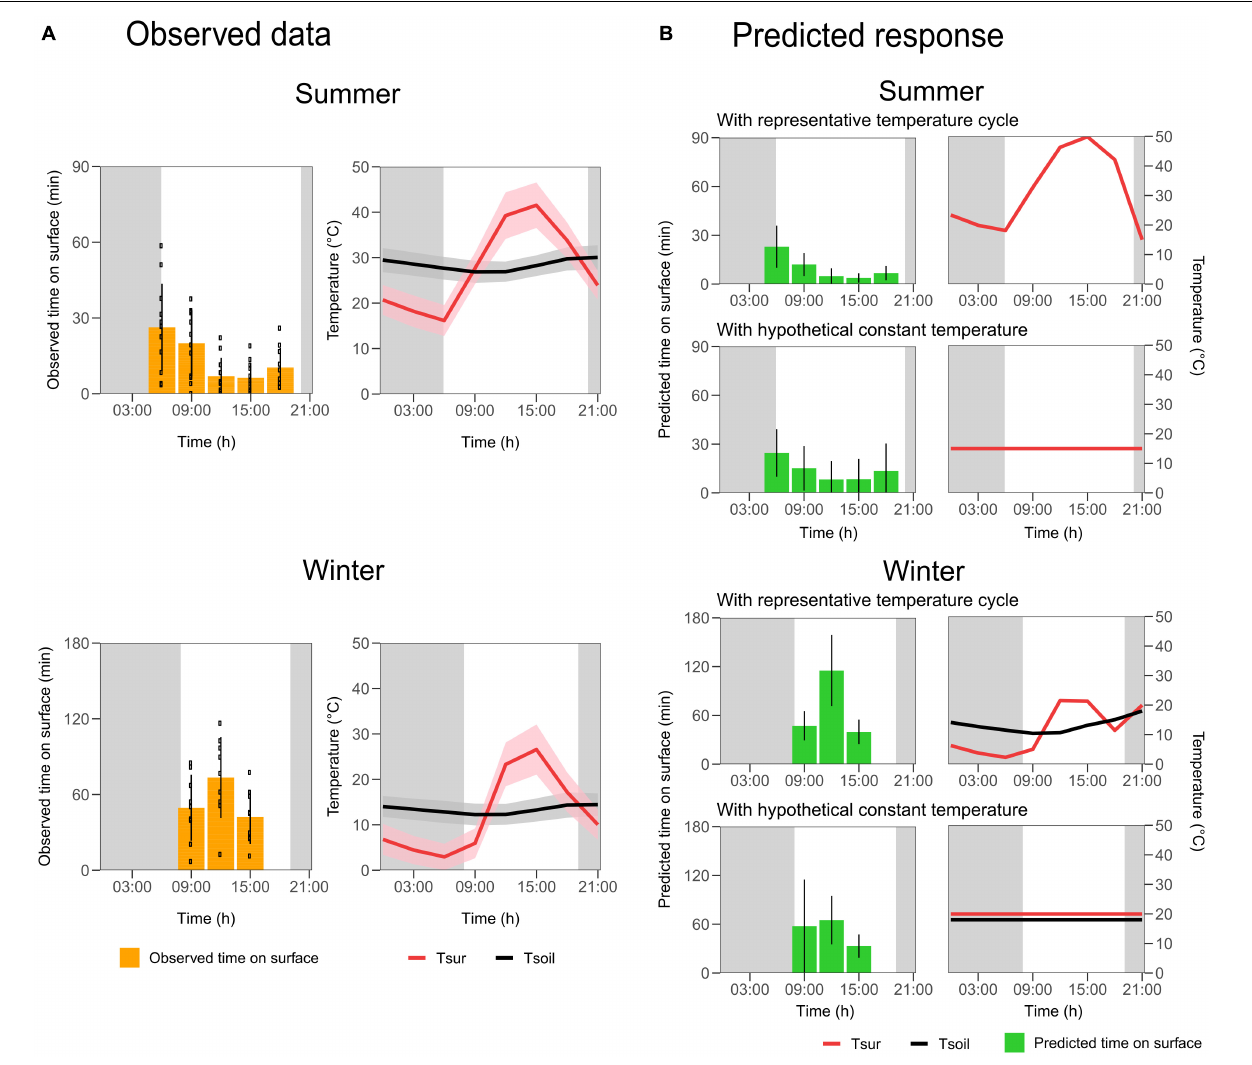
FIGURE 2 | Observed and predicted time tuco-tucos spent on the surface during the light hours of the day, in summer and winter. (A) Left: Observed time spent on surface according to collar light-logger data. Means by animal (black points) for every 3 h were averaged to obtain the overall pattern (yellow bars). Right: Mean and standard deviation (lines and shaded areas) of T sur (red) and T soil (black) every 3 h, during animals’ recordings. (B) Predicted overall pattern of time on surface (green bars) according to the final generalized linear models fitted for summer (above) and winter data (below) assuming two different scenarios: representative natural temperature variation and hypothetical constant temperatures. Vertical lines in the bars: standard deviation of the predictions for each individual. T sur (red lines) and T soil (black lines) used for predictions are shown to the right of the corresponding graph. T soil is not shown for summer since this variable was not significant in the